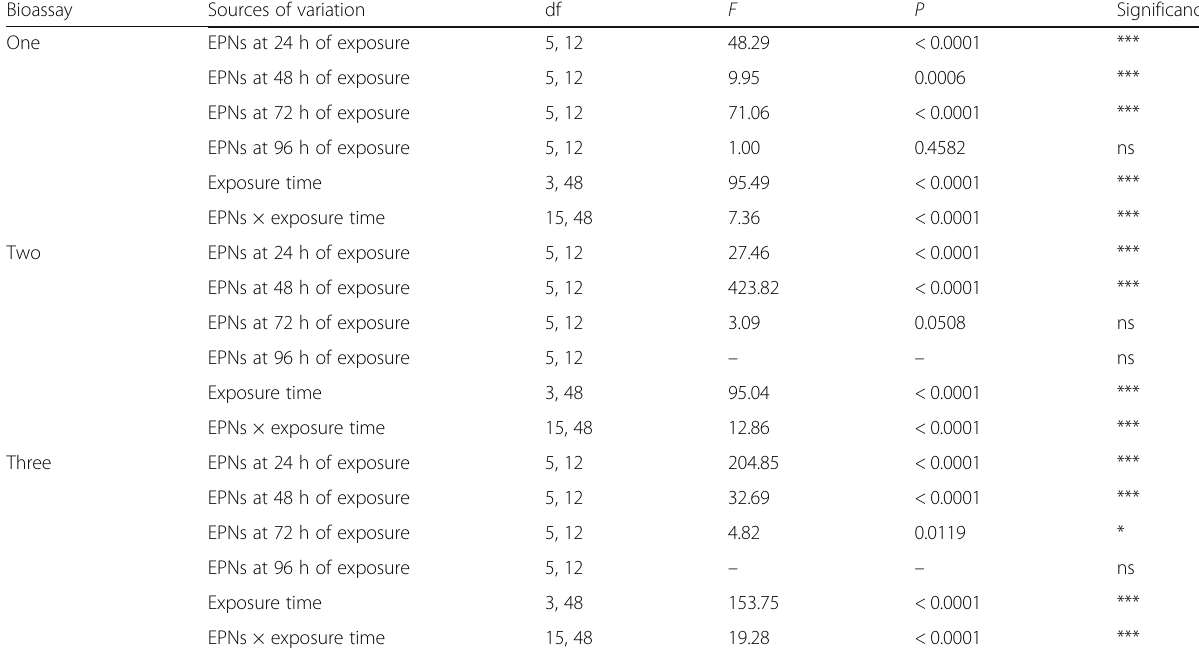
Table 1 GLM analysis for mortality of Tuta absoluta larvae caused by different EPNs used at 500 IJs/ml Bioassay Sources of